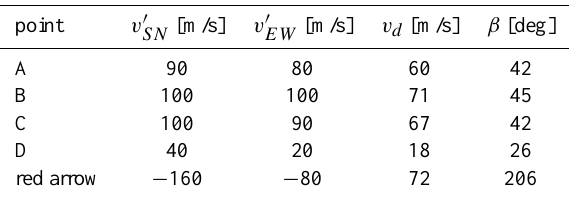
Fig. 10- maxima line with opposite signs of slope within the same frequency range that suggest changing drift velocity